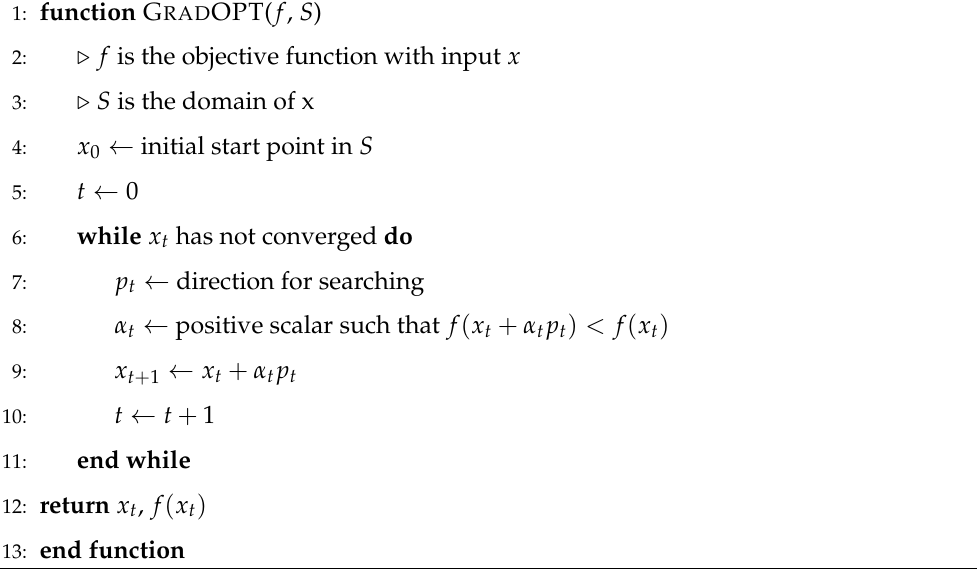
Algorithm 2 Gradient-based optimization for objective function